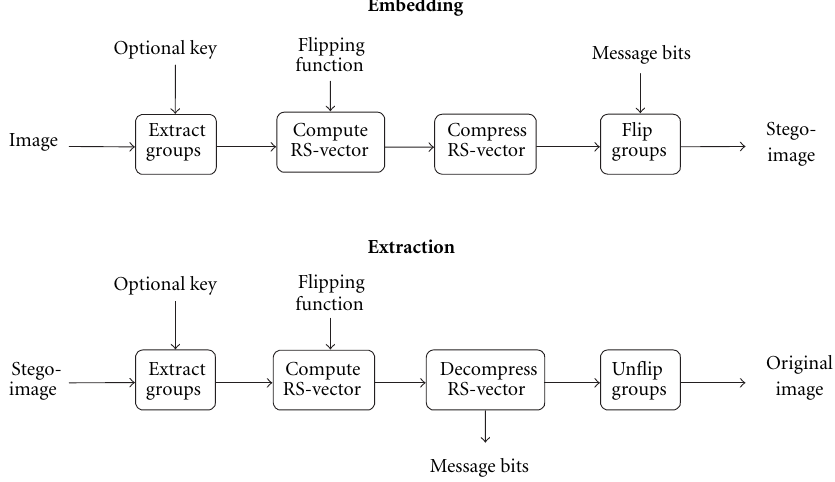
Figure 2: Diagram for the distortion-free data embedding and extraction